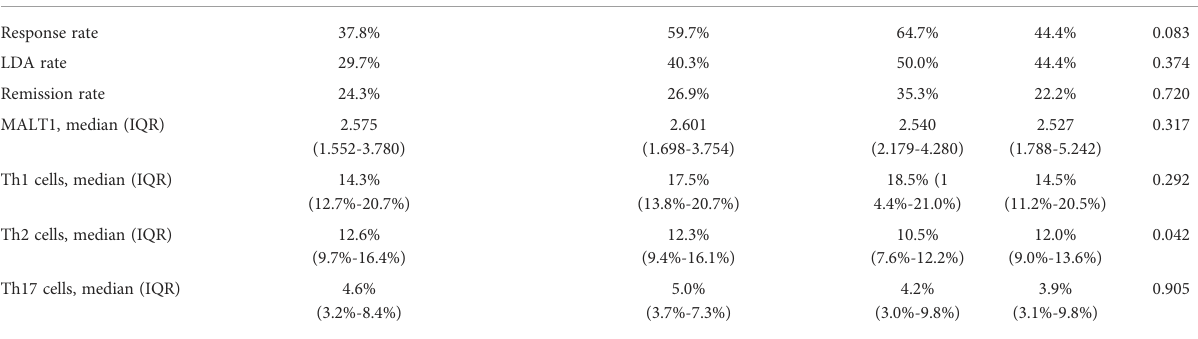
TABLE 3 Correlation of current treatment regimen kinds with outcomes, MALT1 level, and Th cells level in RA patients. Parameters